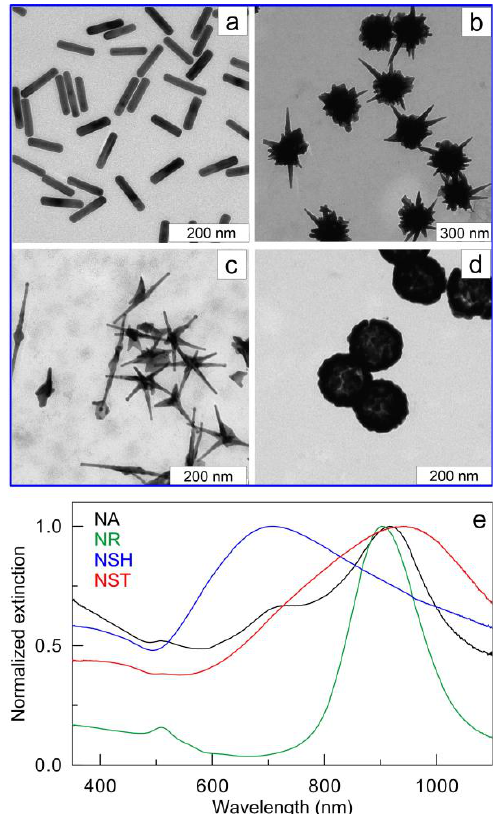
Figure 2. TEM images of AuNRs ( a ), AuNSTs ( b ), AuNAs ( c ), and AuNSHs ( d ) and the correspond- ing normalized extinction spectra ( e ). normalized extinction spectra ( e